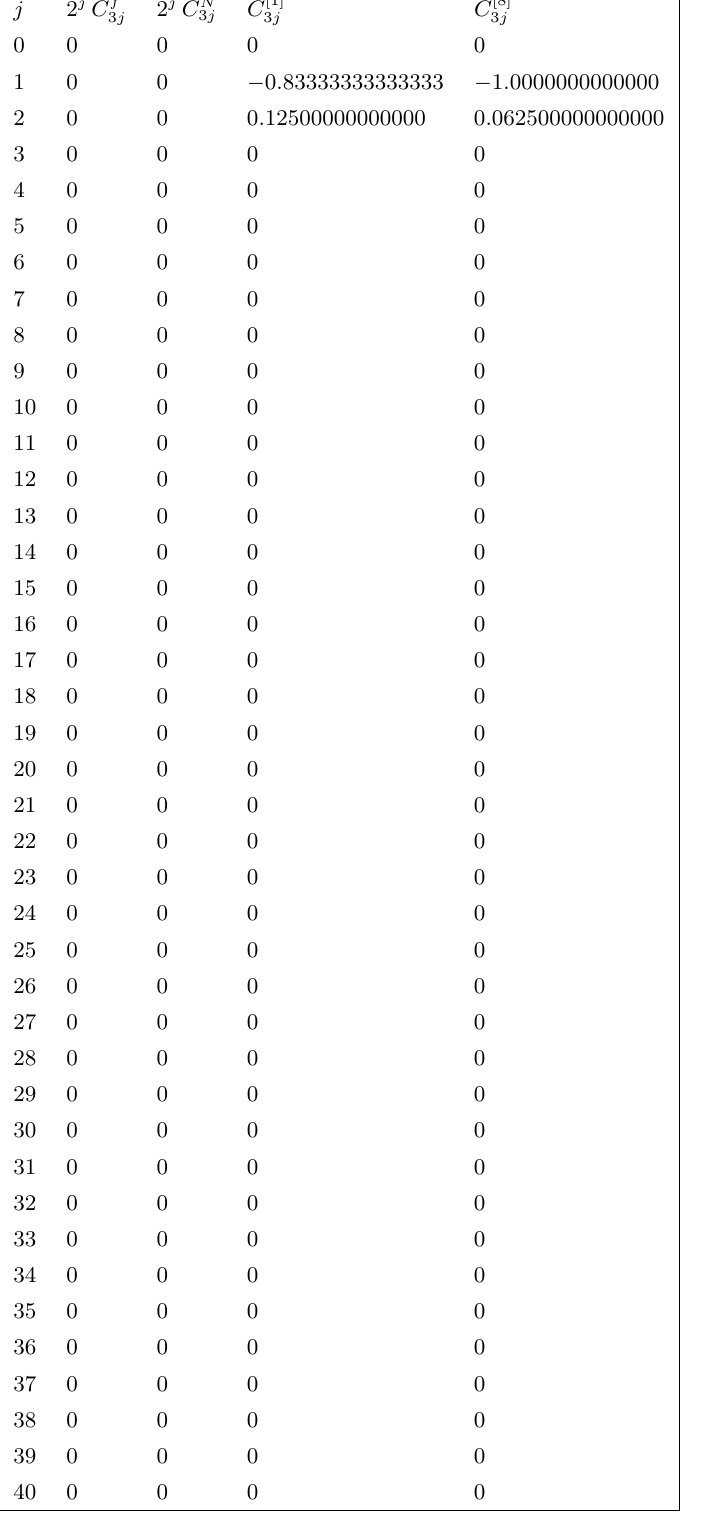
Table 7 . Coe(cid:14)cients of the term including ln 3 (1 (cid:0) z ) in the asymptotic expansion at z =